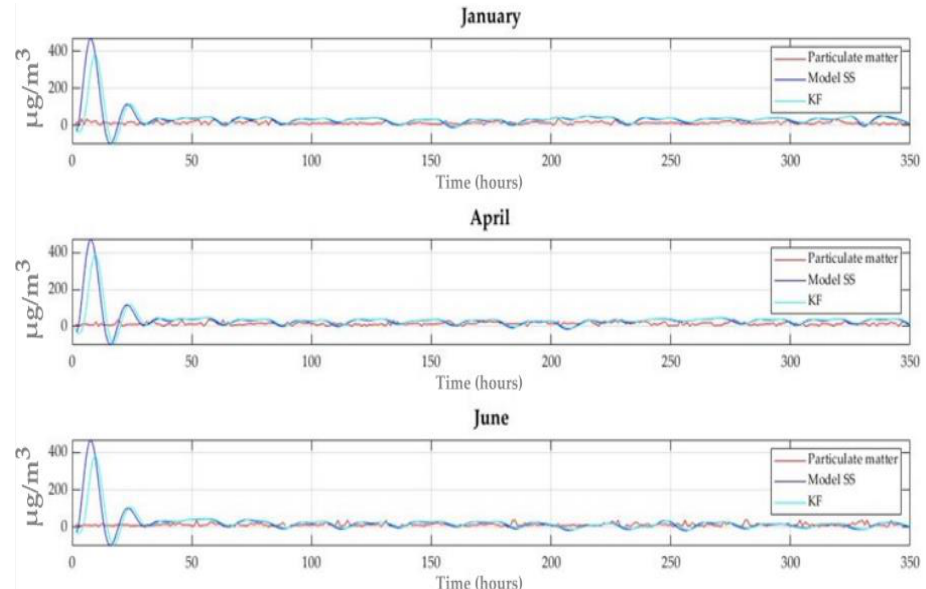
Figure 12. Validation of the model and the filter in the north of Valle de Aburrá.